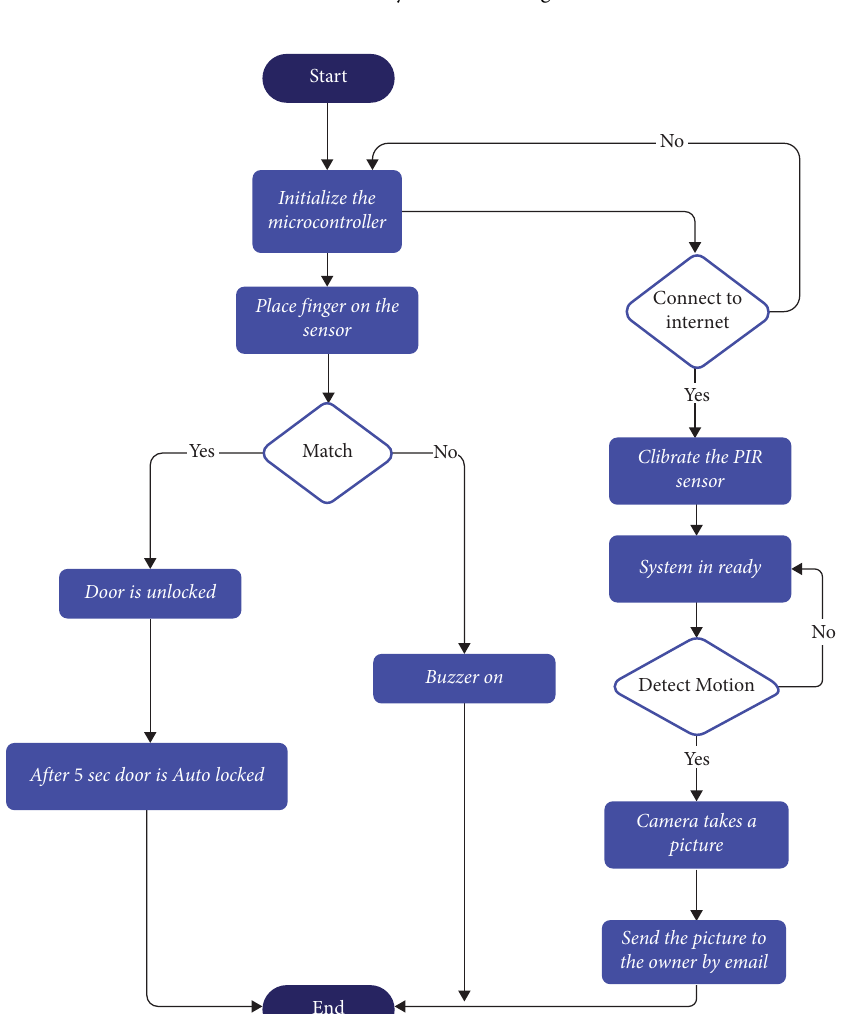
Figure 3: Te fowchart of door